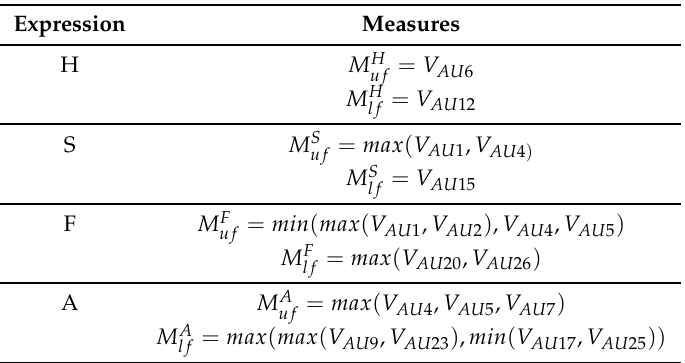
Table 2. Computational measures of production ability for H = Happiness; S = Sadness; F = Fear; A = Anger. lower and upper facial part are indicated by uf and l f subscripts respectively. Time index has been omitted for better table readability.